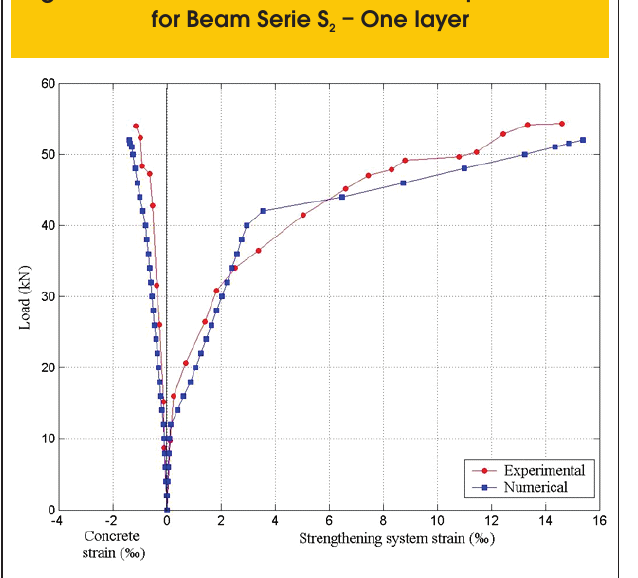
Figure 10 – Load versus Strain in the mid-span section for Beam Serie S – Two layers 2